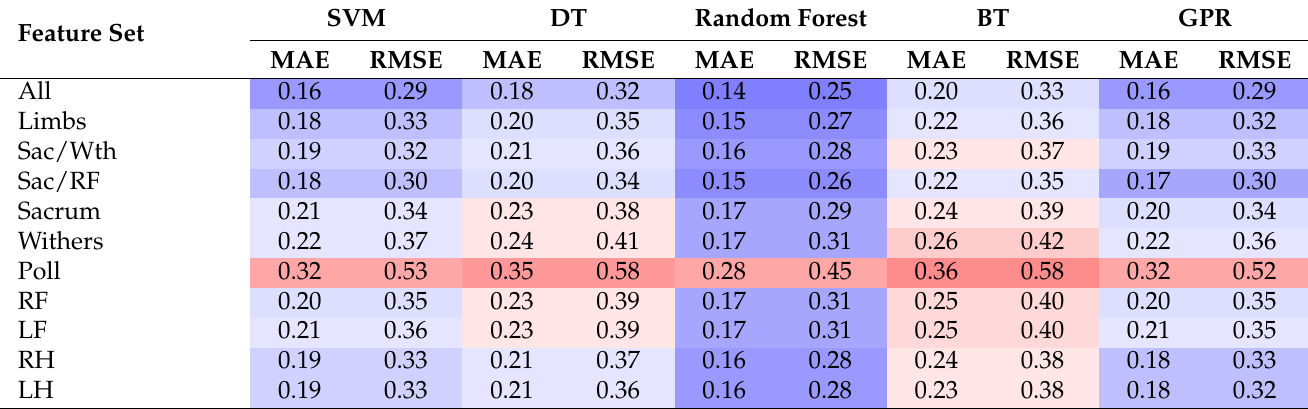
Table 3. Accuracy of the models- MAE(m/s) and RMSE (m/s).